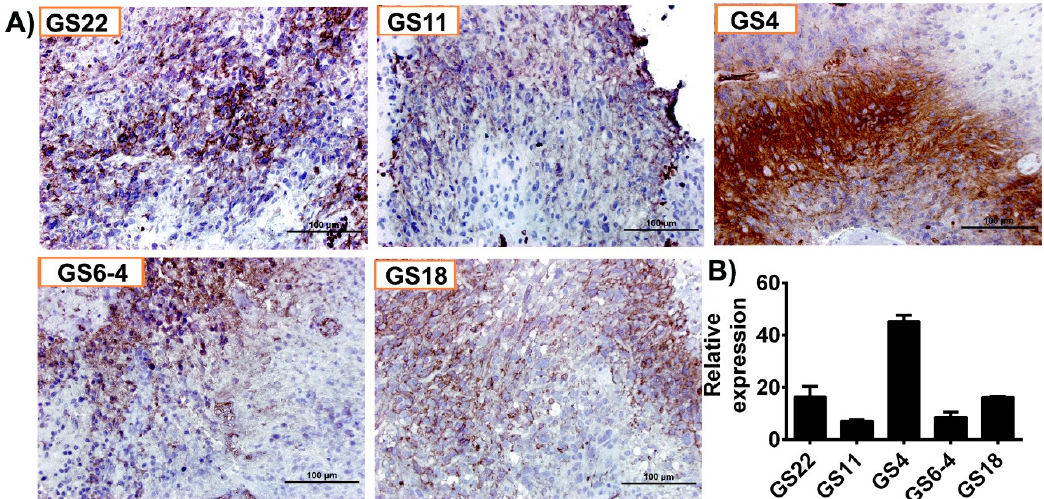
Figure 2. GLUT1 is highly expressed in human glioblastoma (hGBM) surgical biopsies. ( A ) Immunohistochemical staining for GLUT1 with anti-GLUT1 antibody (brown, diaminobenzidine; light blue, nuclear counter stain with DAPI; GS = glioblastoma specimen). ( B ) RT-PCR analysis of GLUT1 from hGBM specimens. GAPDH is used as a loading